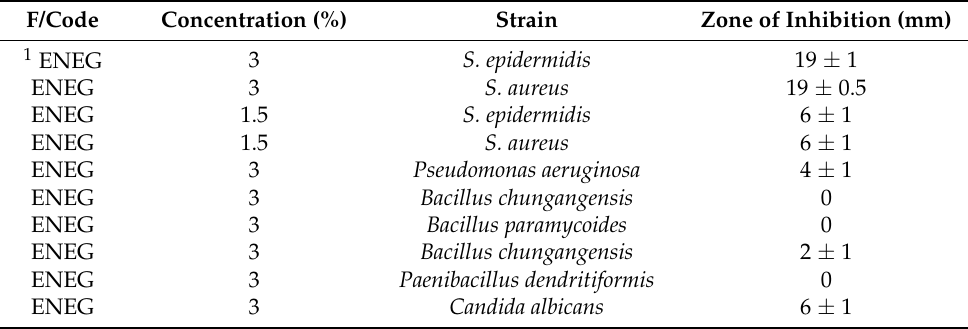
Table 6. Antimicrobial properties of essential oil loaded nanoemulgel. F/Code